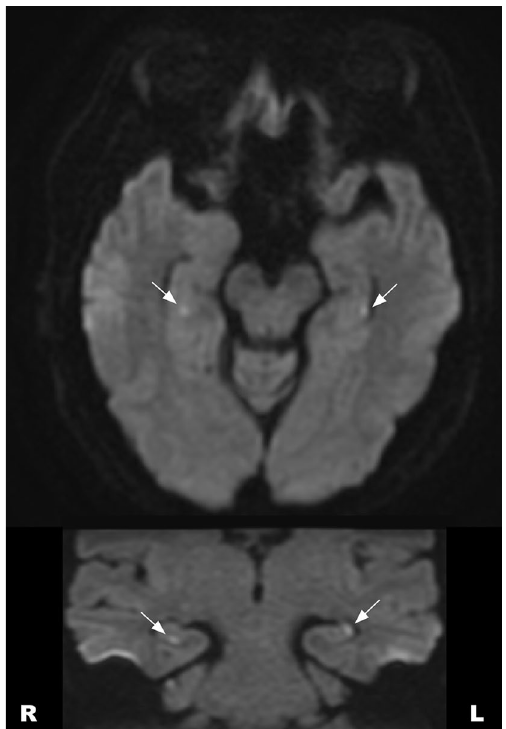
Figure 2. Representative diffusion-weighted MRI showing lesions in a TGA patient. Upper, axial slice; lower, coronal slice. TGA transient global amnesia, MRI magnetic resonance imaging. Arrows indicate hippocampal CA1